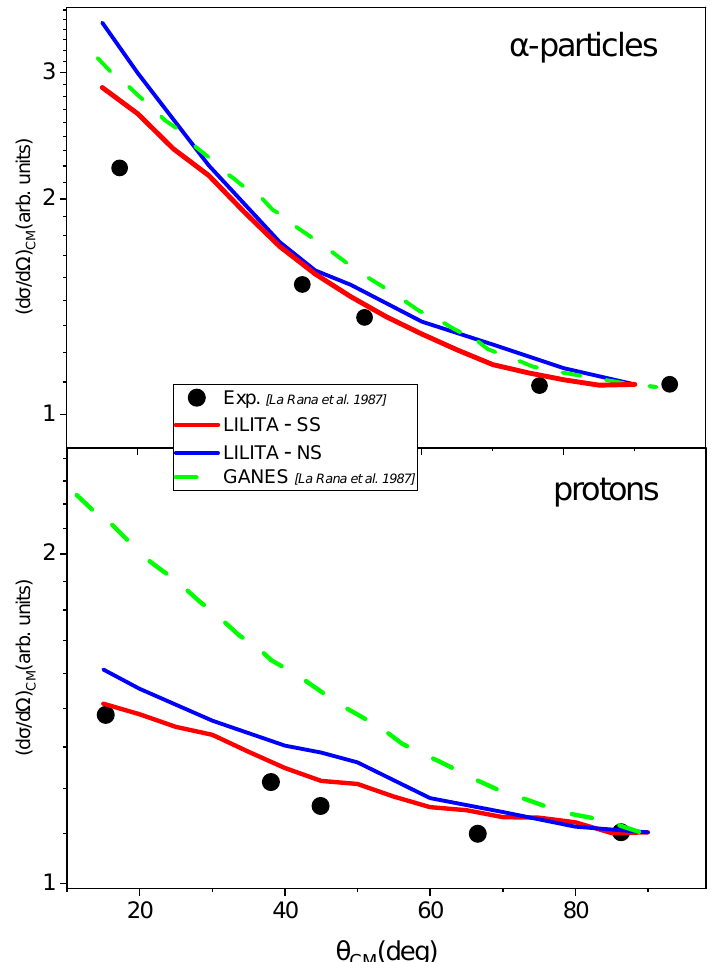
Figure 2. Angular distributions of α particles and protons in the center of mass system. The experi- mental data (dots) from [12] are compared with LILITA_N21 calculations using the SS (solid red line) and NS (solid blue line) and the GANES calculations (dashed green line) assuming emission from spherical nuclei, data from [12]. The calculated curves have been normalized to the data at around 90 ◦ . For more details, see the